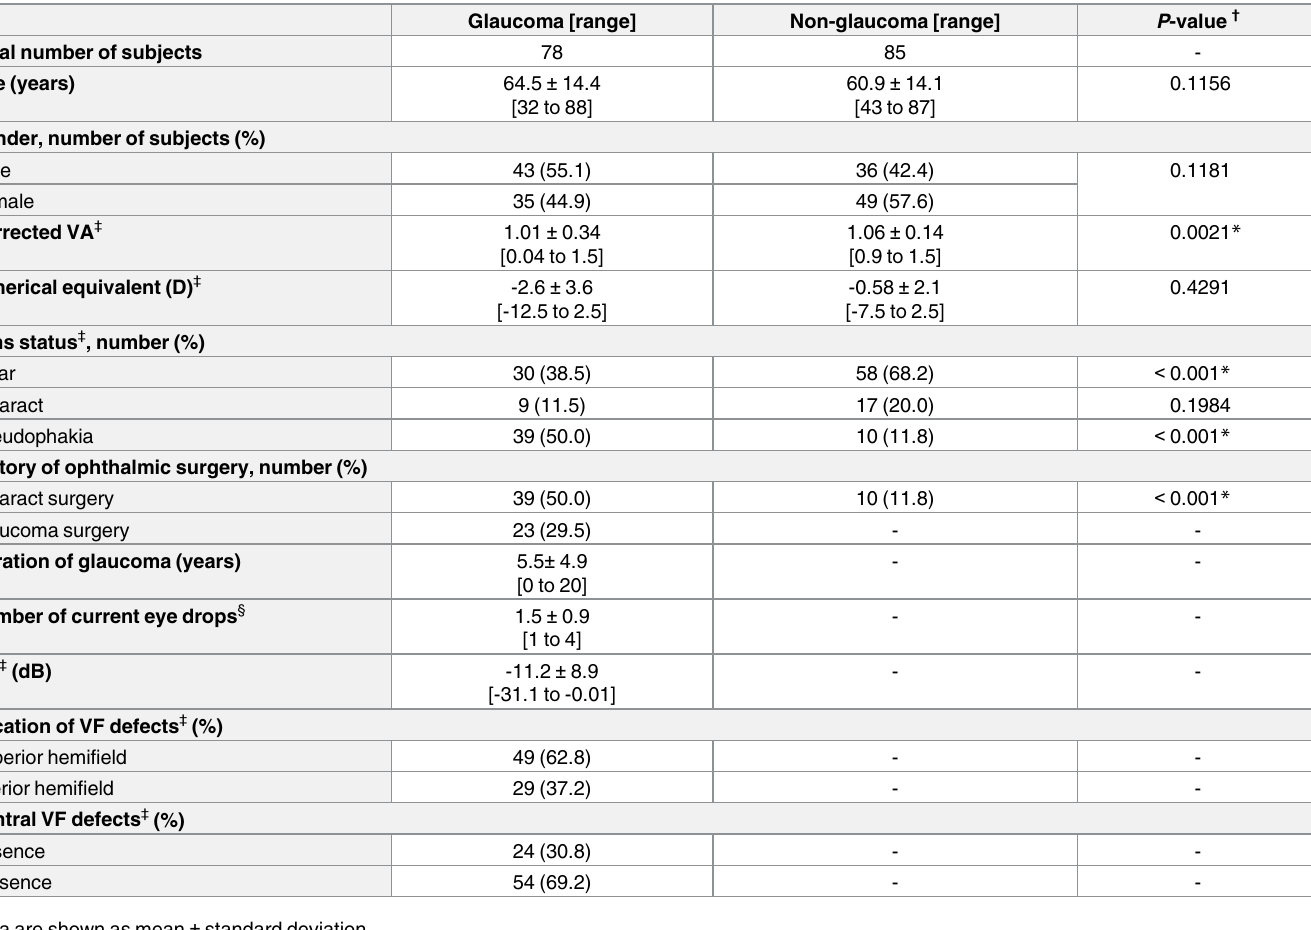
Table 1. Demographic and clinical characteristics of glaucoma and non-glaucoma